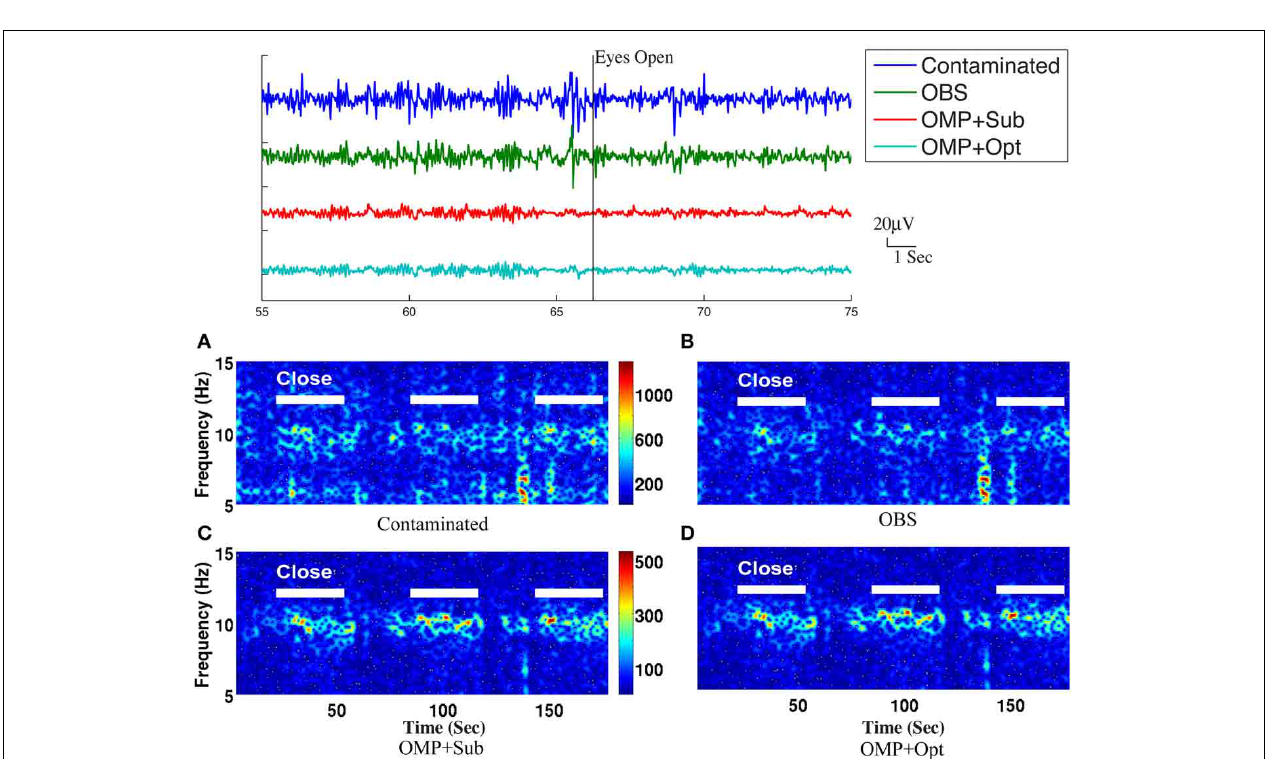
FIGURE 7 | Top panel: Roughly 20-s ranges of reconstructed EEG signals are shown here with event onsets (eyes open and eyes close). Bottom panel: Comparison of performance in differentiating the eyes open (EC) and eyes closed (EO) states: (A) based directly on